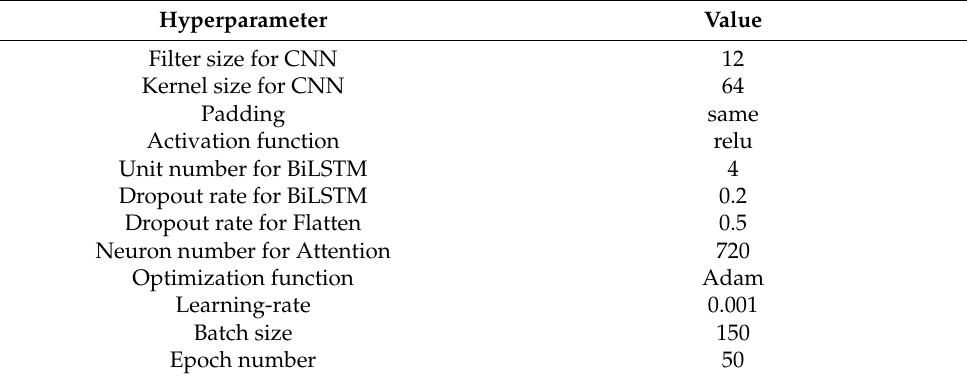
Table 2. Hyperparameters of CNN-BiLSTM-Attention